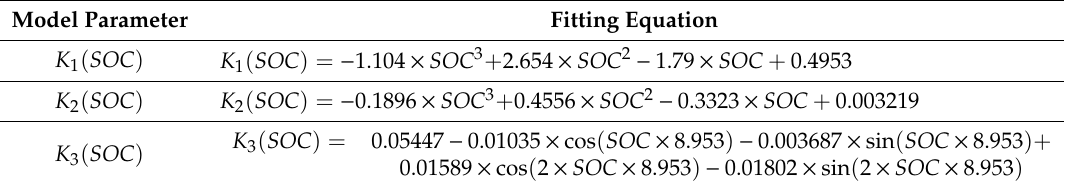
Table 3. Parameters of the temperature-based hysteresis voltage model.